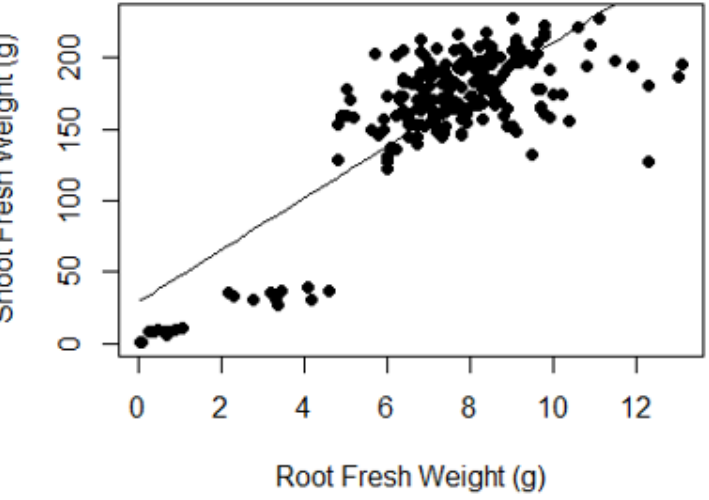
Figure 5. Regression of shoot fresh weight on root fresh weight.